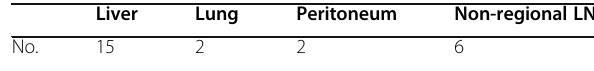
Table 8 Site distribution of metastatic lesions in the 42 studied cases